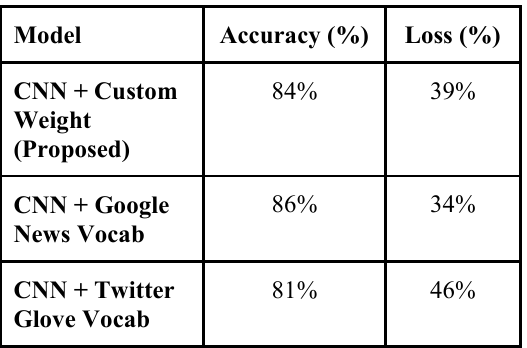
Table 1. Comparison of models